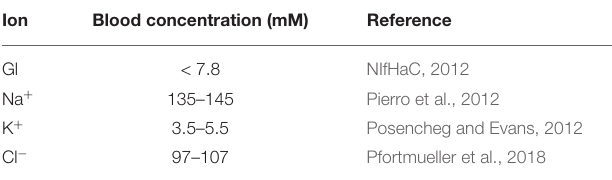
TABLE 2 | Reported values for ions, concentrations in